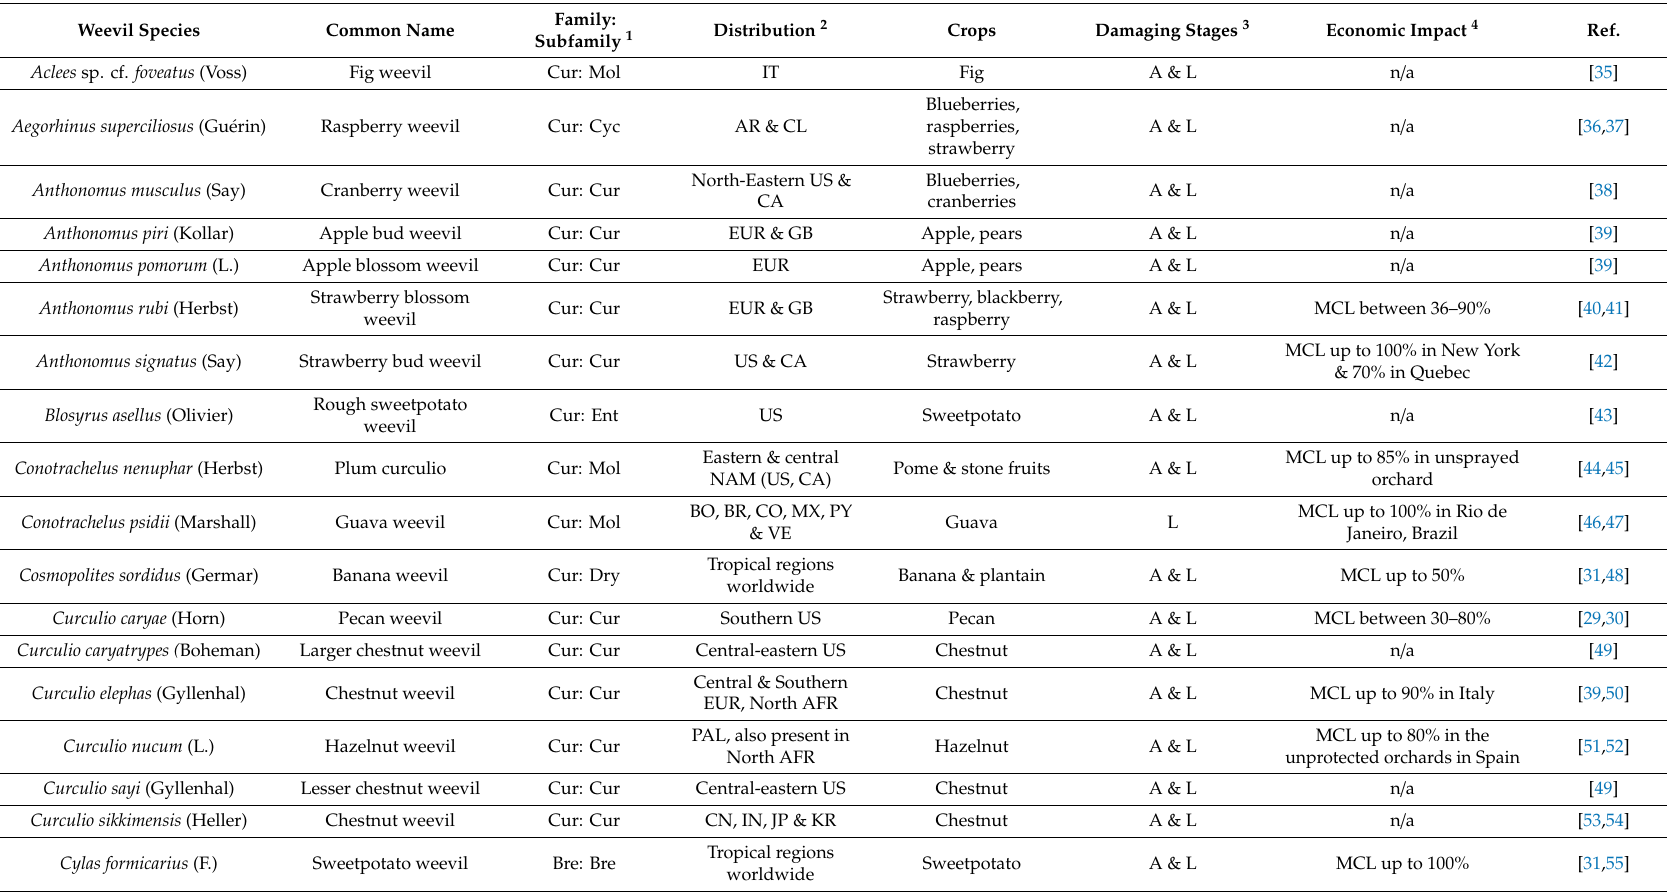
Table 1. Important weevil species of horticultural crops, including crops impacted, geographical distribution and economic